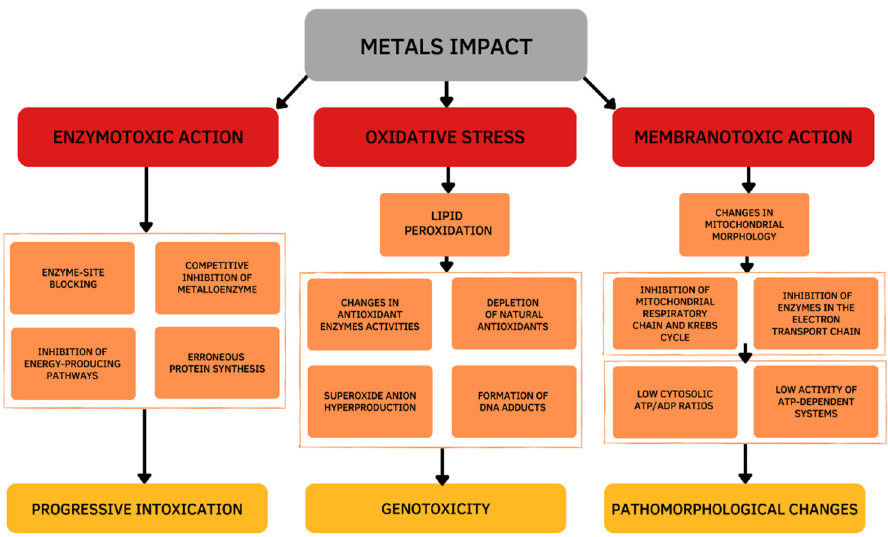
Figure 1. Cellular mechanisms of the metals toxic action.